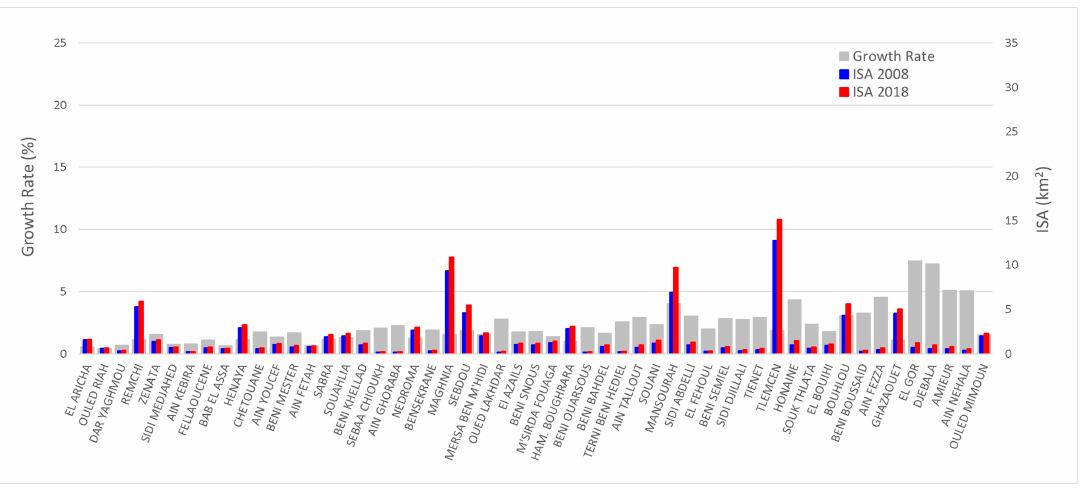
Figure 4. Impervious surface area (ISA) (km 2 ) and its growth rate (1/10 of percent) for the communes in the Tlemcen wilaya between 2008 and 2018.